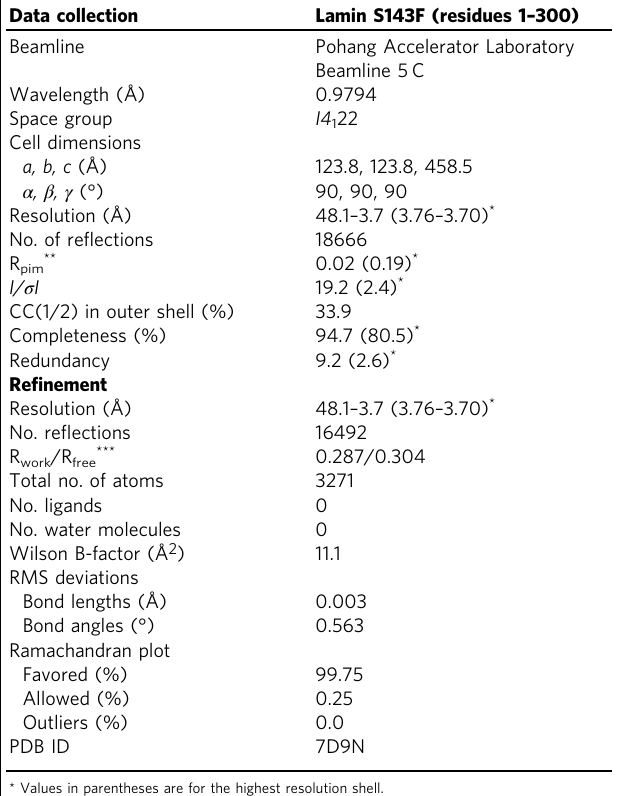
Table 1 X-ray diffraction and re fi nement